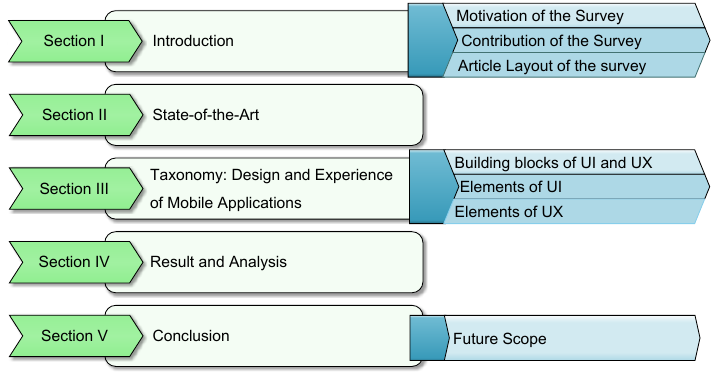
Figure 2. Taxonomy: paper